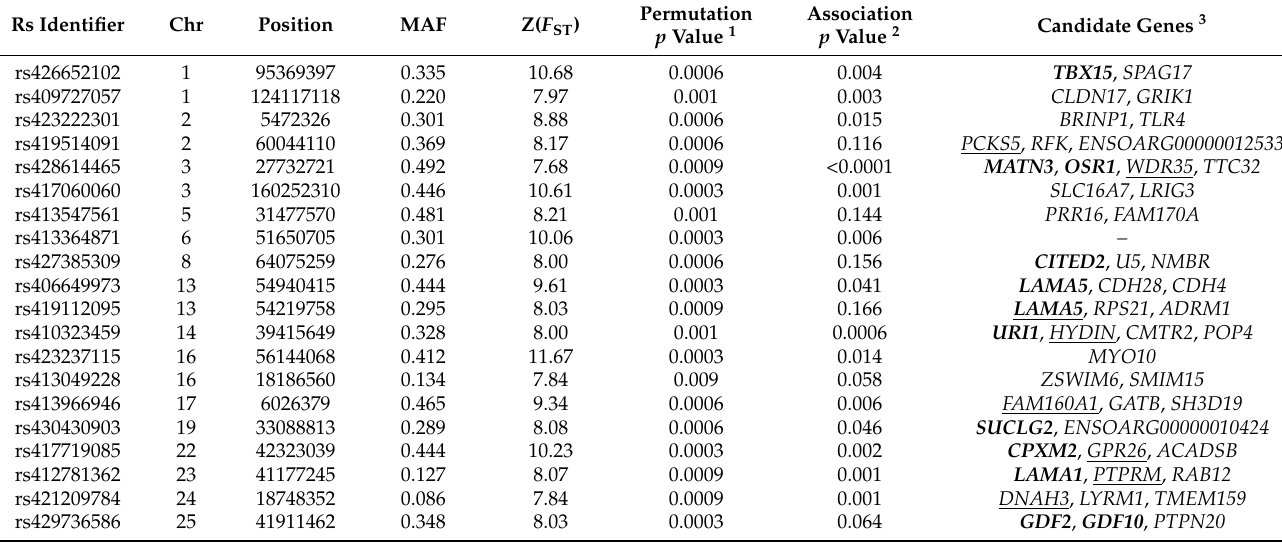
1 p -value resulting from permutation-based test of F 2 p -value resulting from ST values and subsequent adjustment for genomic inflation; association analysis of the respective SNP with birth weight; 3 Gene names in bold = functional candidate genes, underlined = positional candidate genes, only italic = closest up- and downstream-located genes within a 2 Mb window, Chr = chromosome, MAF = minor allele frequency, Z( F ST ) = SNP-specific Z-transformed fixation